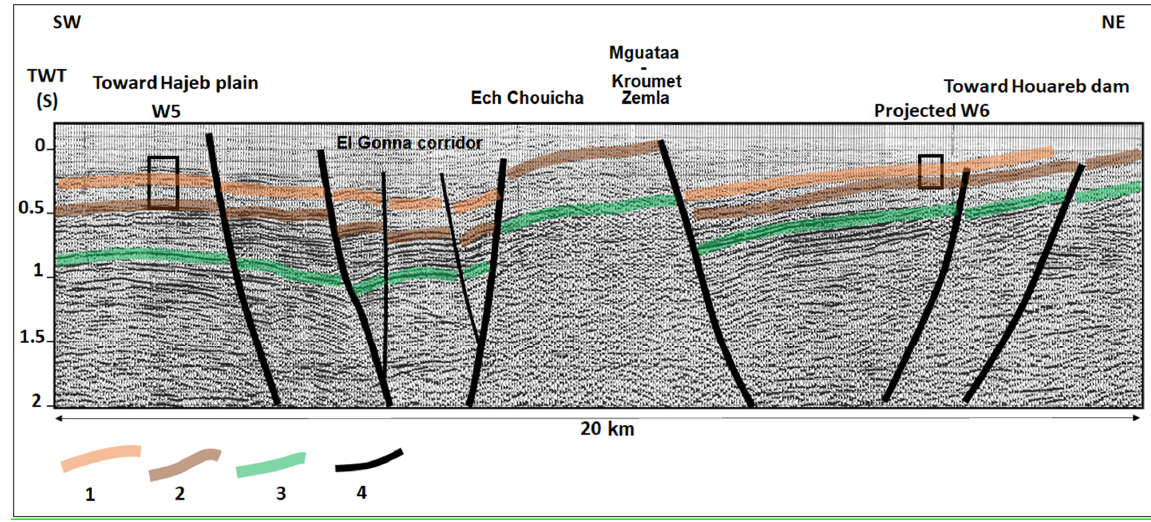
Figure 11. Interpreted seismic reflection profile L2. (1) Top. Oligocene. (2) Top. Eocene. (3) Top. Upper Cretaceous. (4) Major fault.